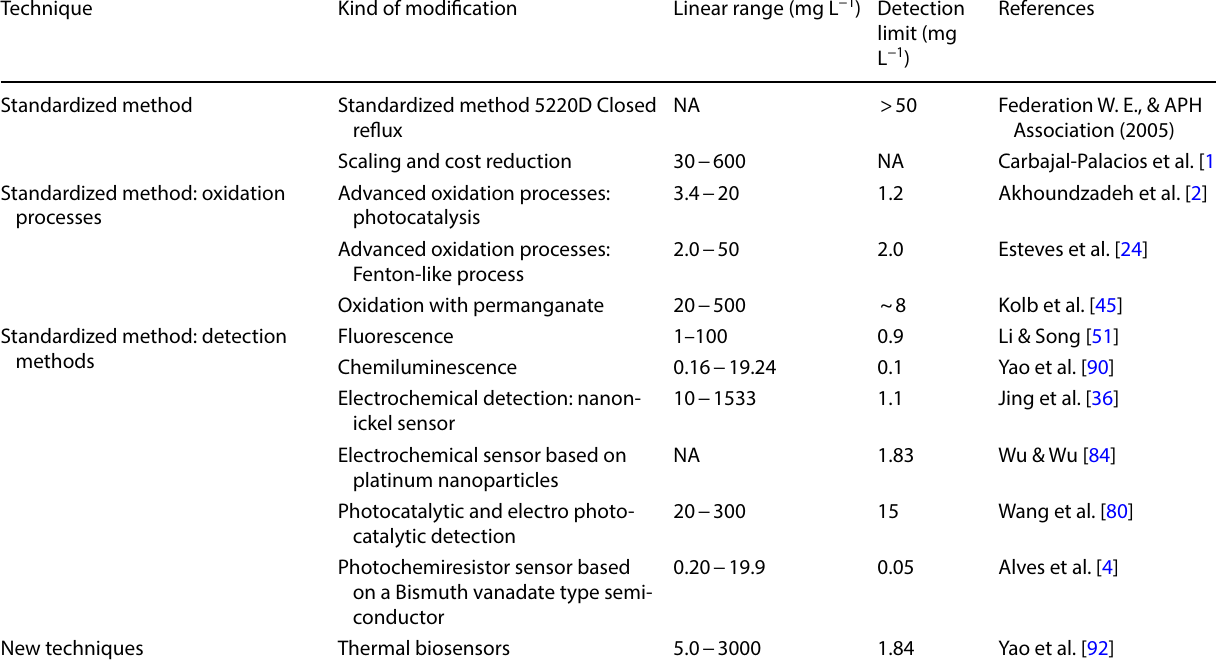
Table 1 Techniques used as alternatives for COD